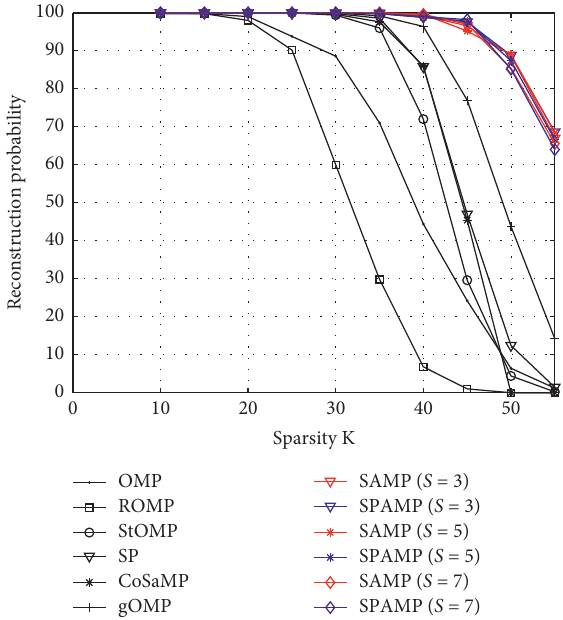
Figure 5: Probability of exact recovery versus the signal sparsity ( M �